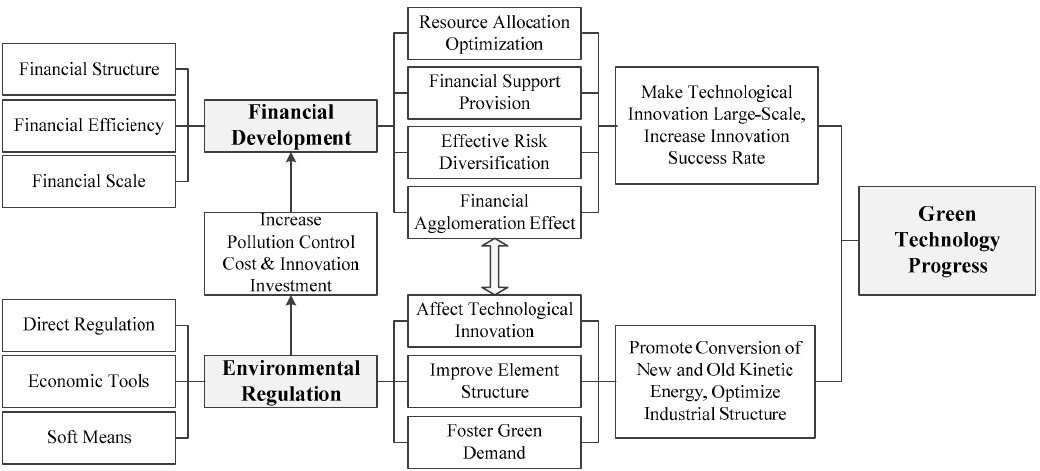
Figure 1. Influence mechanisms of environmental regulation and financial development on green technological progress.